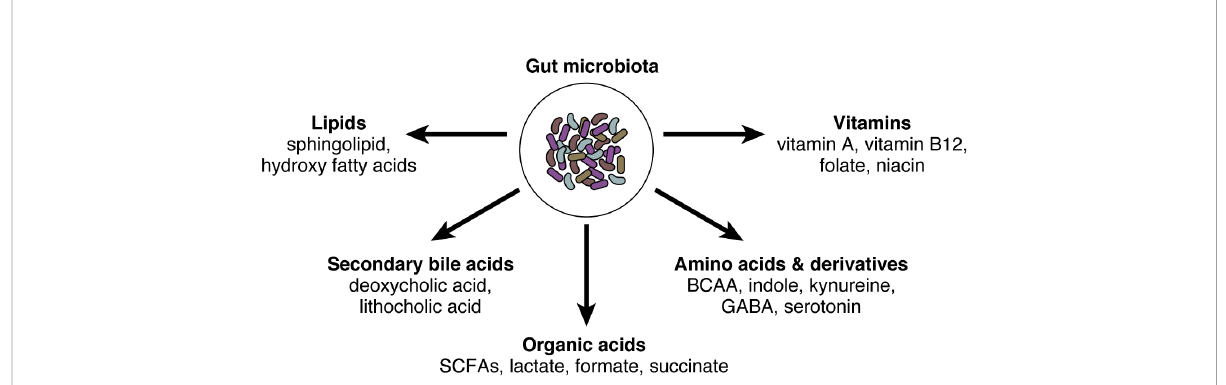
FIGURE 1 The gut microbiota and their small molecules. The gut microbiota possesses millions of genes and produces thousands of small molecules. Here we summarized representative microbe-derived small molecules, including organic acids, amino acids and their derivatives, vitamins, secondary bile acids, and lipids. SCFAs, short-chain fatty acids; BCAA, branched-chain amino acids; GABA, gamma-aminobutyric